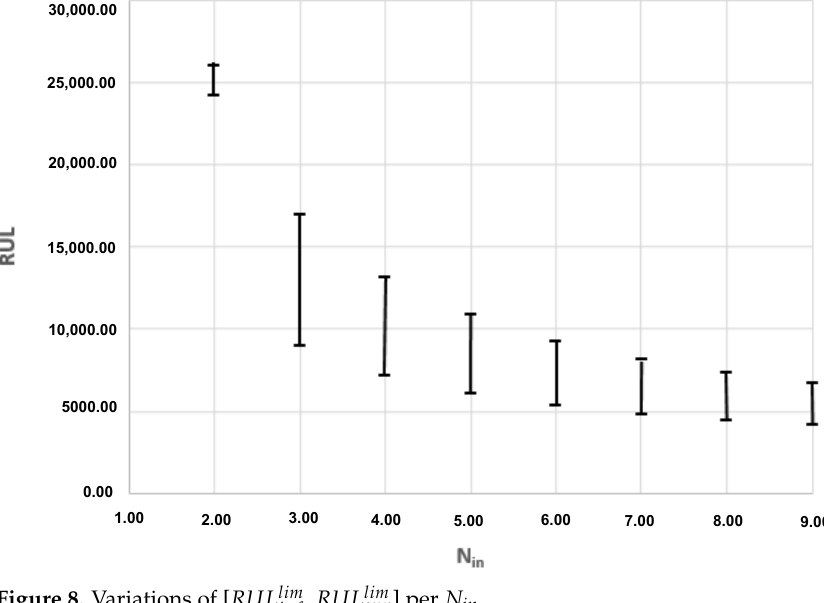
, RUL lim sup ] per N in . inf